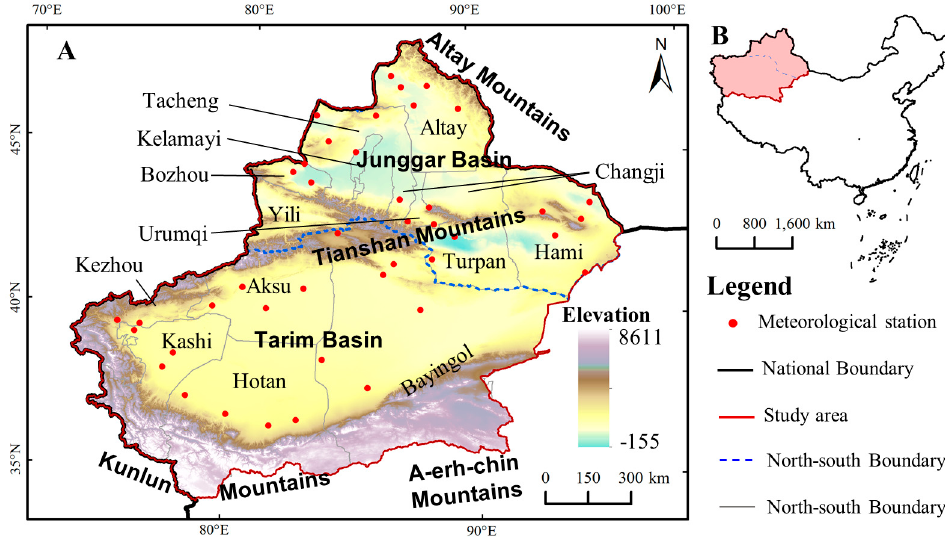
Figure 1. Location of the study area of Xinjiang ( A ) in China ( B ). The figure was mapping based on the Standard Map NO.GS (2016)2923, which could be downloaded from the Ministry of Natural Resources in China (http://bzdt.ch.mnr.gov.cn/). The elevation data was collected from Resource and Environment Data Cloud Platform of China (http://www.resdc.cn/AchievementList1.aspx).